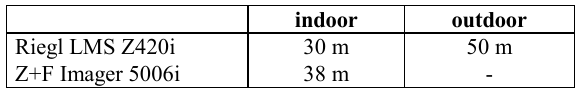
Table 2. Measurement setup and applied maximum ranges